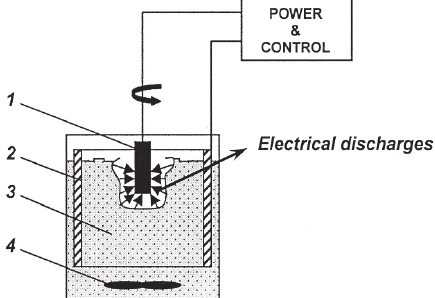
Figure 1: Electrical discharge treatment in electrolyte: 1 – workpiece, 2 – electrode, 3 – electrolyte, 4 – magnetic